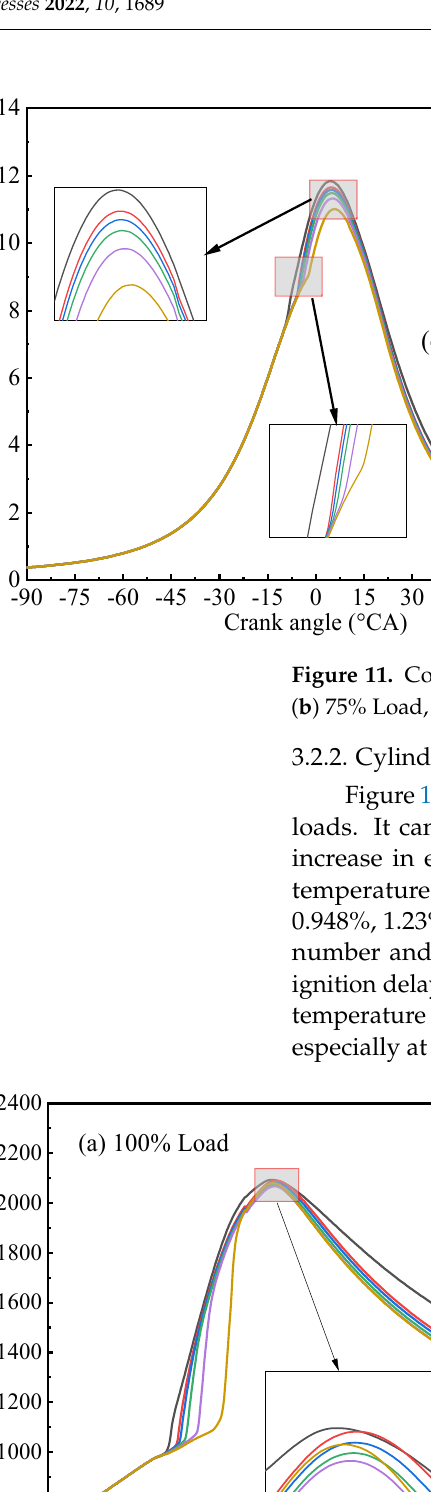
(d) 25% Load Figure 12. Cont